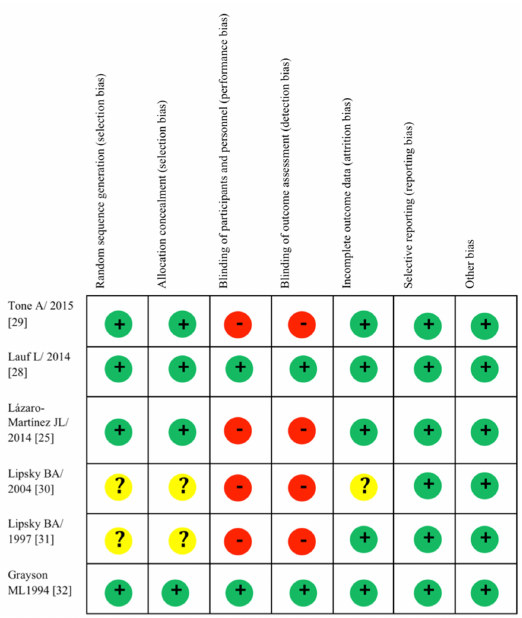
Figure 2. Quality assessment (Cochrane Risk of Bias tool) for included RCTs. A green circle with a plus sign indicates a low risk of bias, a yellow circle with a question mark indicates an unclear risk of bias, a red circle with a minus sign indicates a high risk of bias.